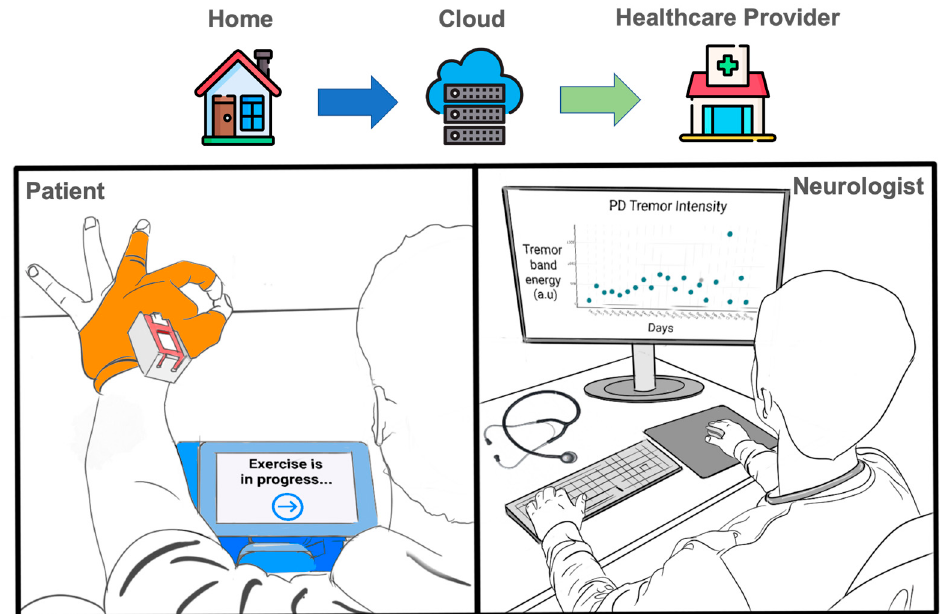
Figure 1. An overview of the iTex system ( left ). User performing movement exams while wearing iTex gloves at home. Clinician reviewing movement symptom analytics over a period from the clinic ( right ).